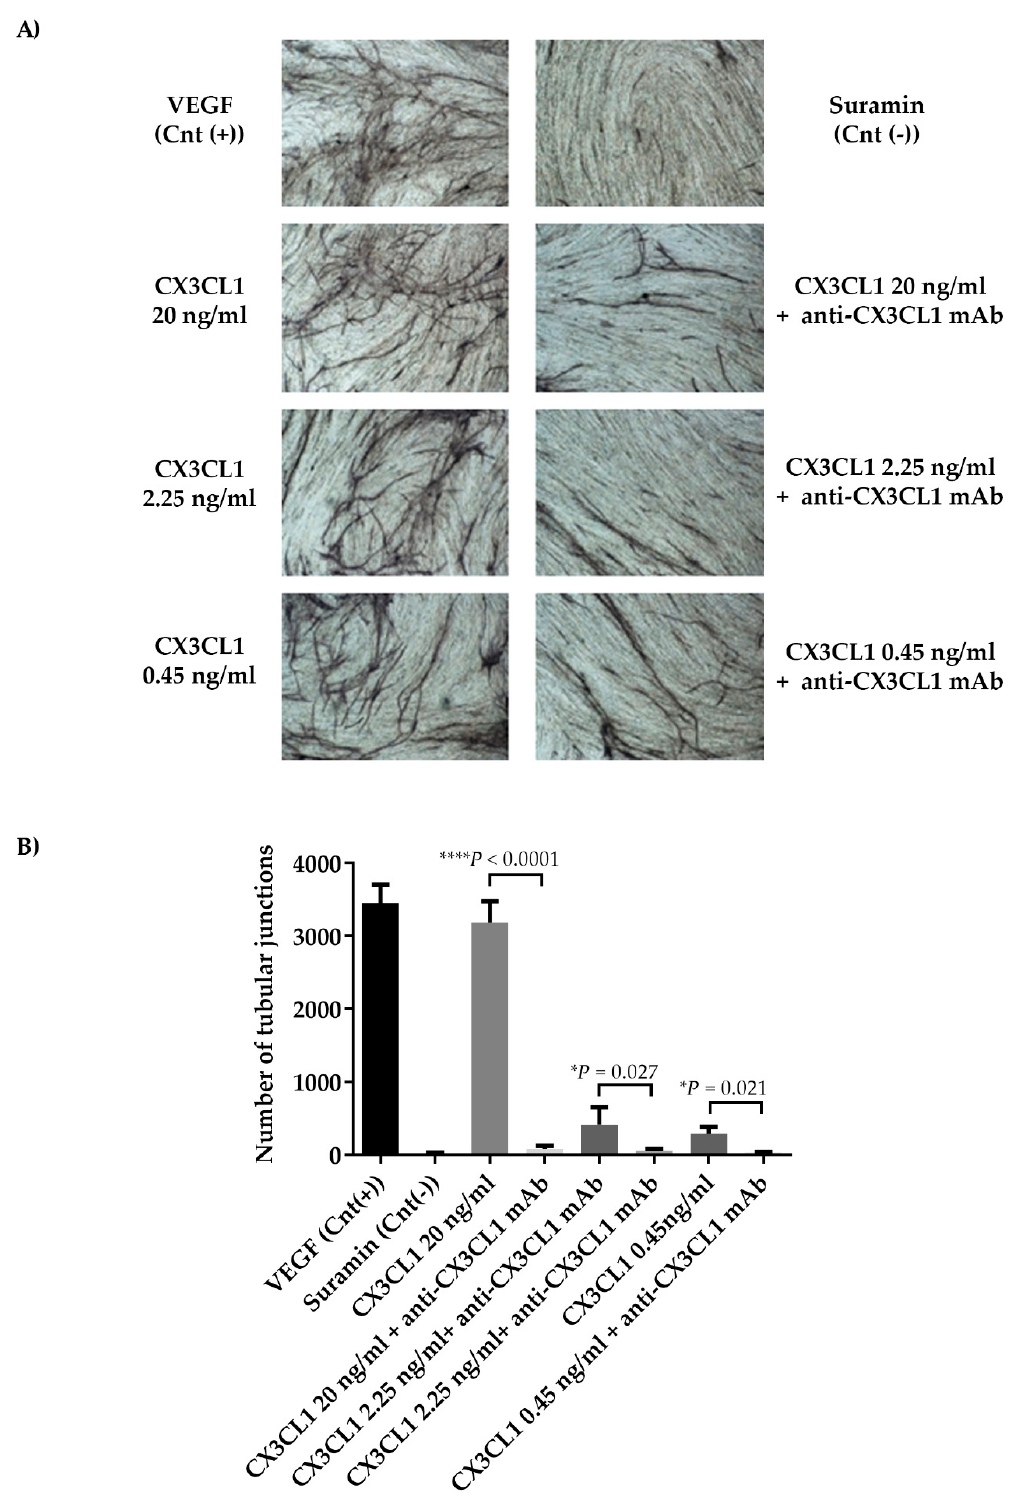
Figure 7. ( A ) In vitro angiogenic property of CX3CL1. The Angiokit co-culture of HUVEC and fibroblast cells was stimulated for 14 days with the recombinant human (rh) CX3CL1 at different concentrations (ranging 0.45–20 ng/mL) in the presence or absence of blocking anti-CX3CL1 monoclonal antibody (mAb) (0.6 µ g/mL) (positive control: V2a Growth Medium added with VEGF; negative control: V2a Growth Medium added with suramin). ( B ) The graph represents the mean ± SD values of the number of tubular junctions of two replicates ( P values were calculated by two-tailed Student’s t -test) quantified with Angioquant